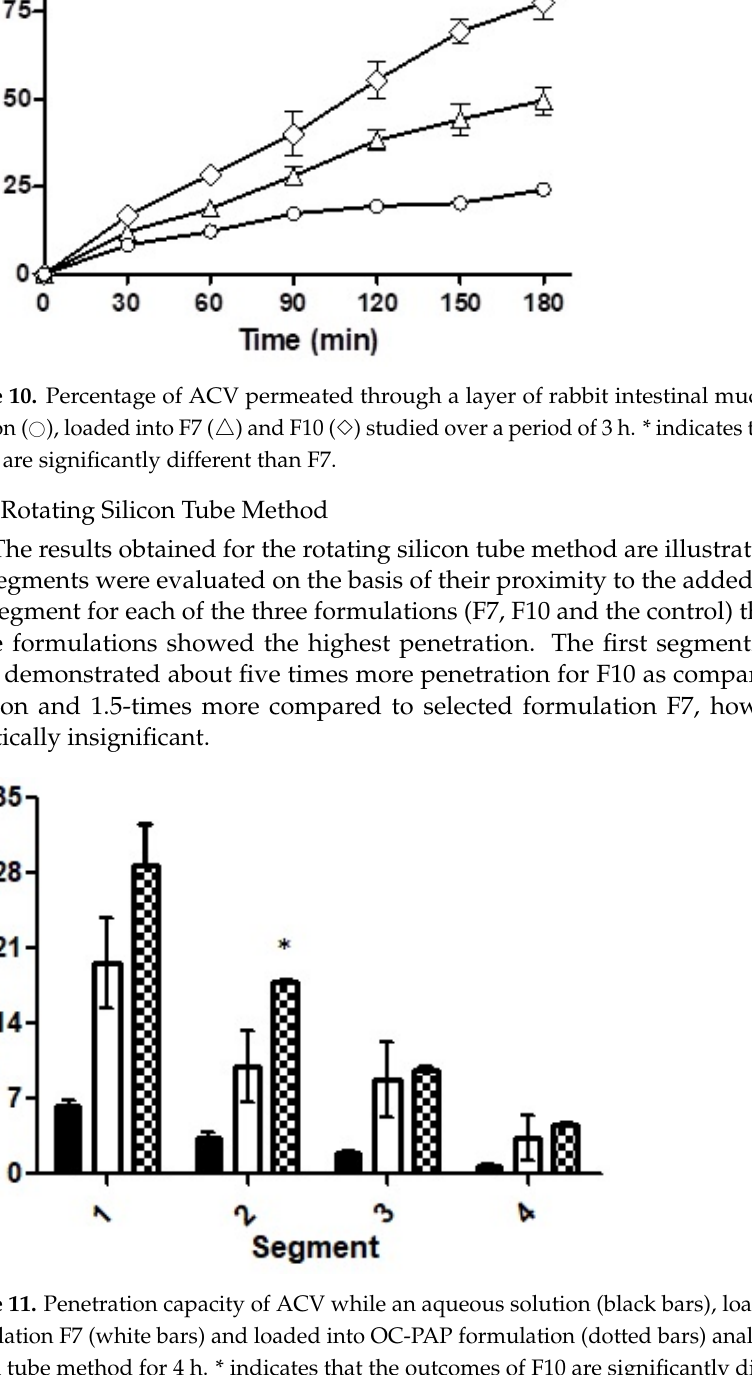
13 of 19 Figure 9. Viability percentage of HCT-116 cells after 4 h of exposure to 0.5% nanoemulsions with OC (F7) and OC-PAP (F10). MEM alone served as negative control, whereas, 1% triton X-100 solution in MEM was taken as positive control. The values are described as means of three experiments ± standard deviation. 3.7. Mucous Permeation Potential 3.7.1. Trans-Well Method Mucus permeation potential was determined for the drug-loaded F7 and F10 via the trans-well method and the results are depicted in Figure 10. In the starting half an hour of the study, the drug penetration from the nanoemulsions was very comparable with F7, which showed a mucous permeability of 12% while there was a 16.69% mucosal drug